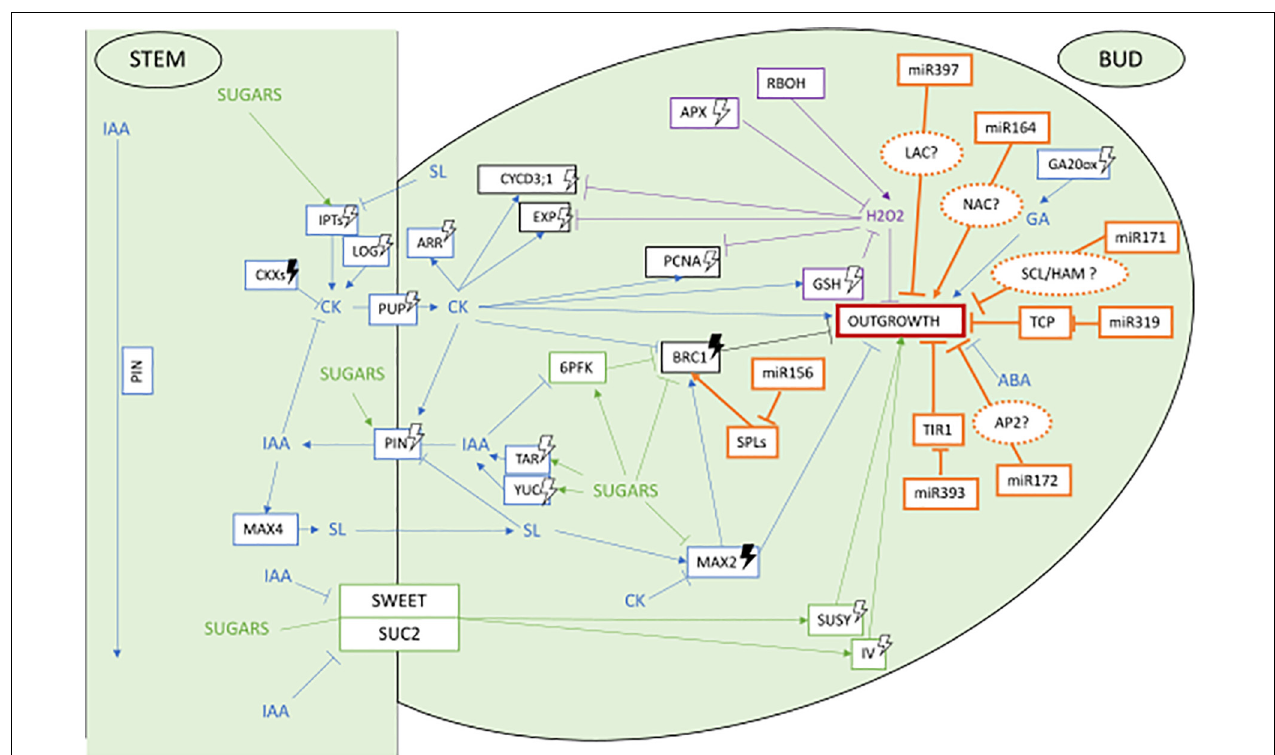
FIGURE 1 | Network of main actors controlling axillary bud outgrowth in the rosebush Rosa ‘Radrazz’* and the potential targets of miRNAs based on literature in other plant species** Potential gene targets of these miRNAs in the control of bud outgrowth are represented in dotted orange circles. miRNAs involved in control of bud outgrowth according to the literature are represented in orange. Blue represents hormonal pathway, green sugars pathway, purple ROS pathway. Arrows head means induction, straight lines mean repression, white lightning bolt means induction by light, darked lightning bolts means induction by darkness. *Girault et al. (2008), Girault et al. (2010), Henry et al. (2011), Choubane et al. (2012), Rabot et al. (2012), Rabot et al. (2014), Djennane et al. (2014), Barbier et al. (2015), Roman et al. (2016), Roman et al. (2017), Porcher et al. (2020), Porcher et al. (2021), Wang M. et al. (2021). **Jiao et al. (2010), Miura et al. (2010), Wang et al. (2010), Wei et al. (2012), Xia et al. (2012), Curaba et al. (2013), Zhou et al. (2013), Zhang et al. (2013), Aung et al. (2015), Wang L. et al. (2015), Wang Y. et al. (2015), Huang et al. (2017), Kravchik et al. (2019), Sun et al. (2019), Cui et al. (2020), Lian et al. (2021), Wang R. et al. (2021), Zhan et al.